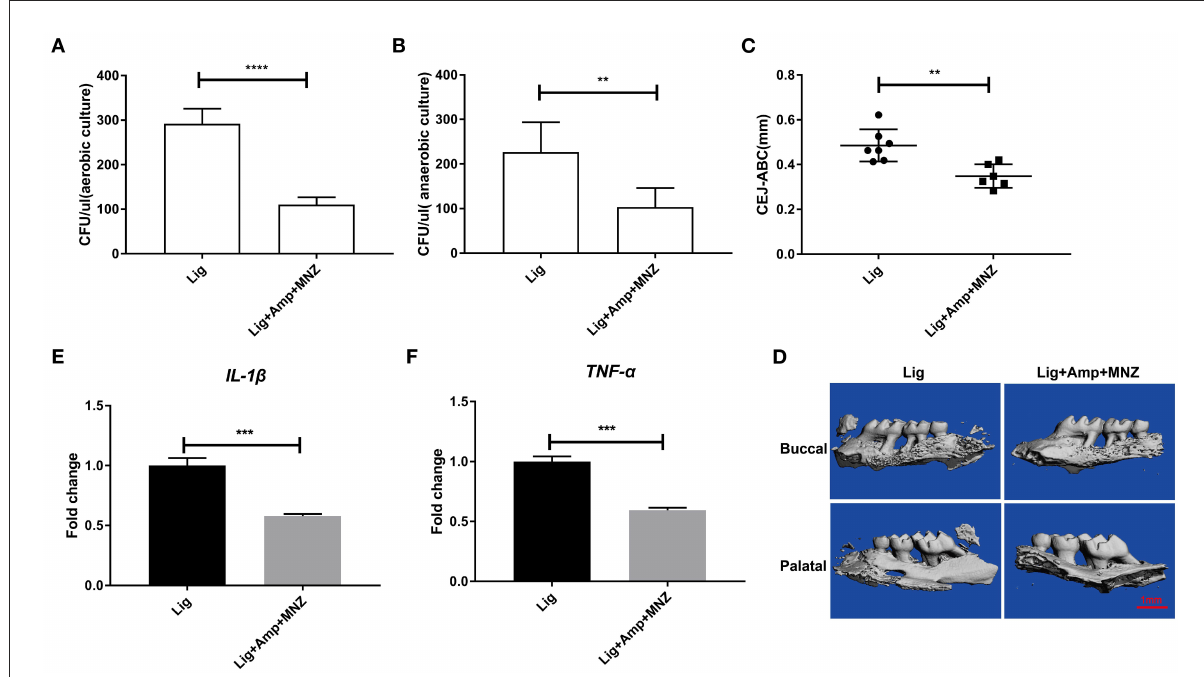
FIGURE4 Bone resorption was decreased following antibiotic treatment. Numbers of bacterial colonies in oral cavities of mice under (A) aerobic and (B) anaerobic conditions. (C) The linear distance of CEJ-ABC after antibiotic treatment of mice. (D) Representative sagittal 3D images viewed from the buccal side and palatal side of the maxillary molars using Micro-CT, scar bar, 1mm. The mRNA expression levels of IL-1 β (E) and TNF- α (F) . Data represent 3 independent experiments ( n = 6). ** P < 0.01, **** P <